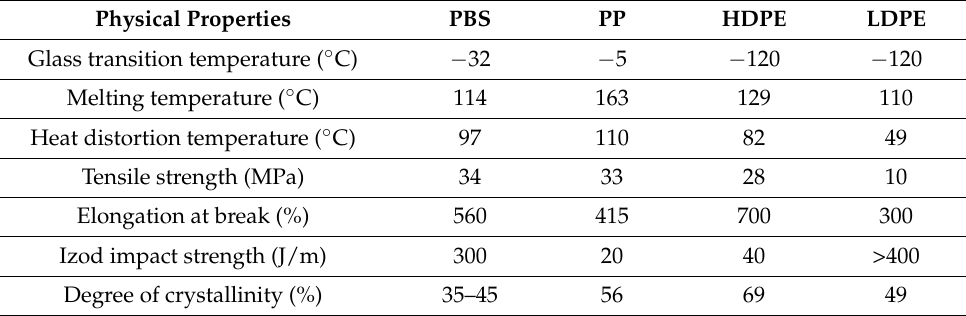
Table 2. Physical properties of PBS as compared with those of polyolefins such as polypropylene (PP), high density polyethylene (HDPE) and low-density polyethylene (LDPE) [24]. Copyrights obtained with permission from Wiley. Physical Properties PBS PP HDPE LDPE Glass transition temperature ( ◦ C) − 32 − 5 − 120 − 120 Melting temperature ( ◦ C)